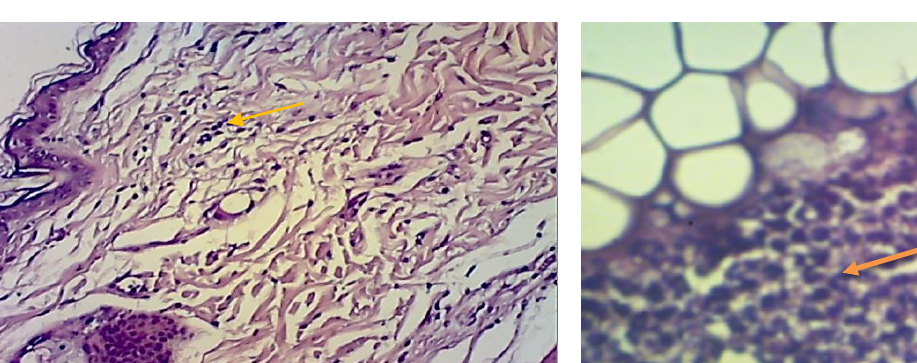
Figure, 3: Ear of animal at 48 hr. post infection show purulent exudates in the middle ear cavity and focal thickness in the mucosa H& E stain 40X.